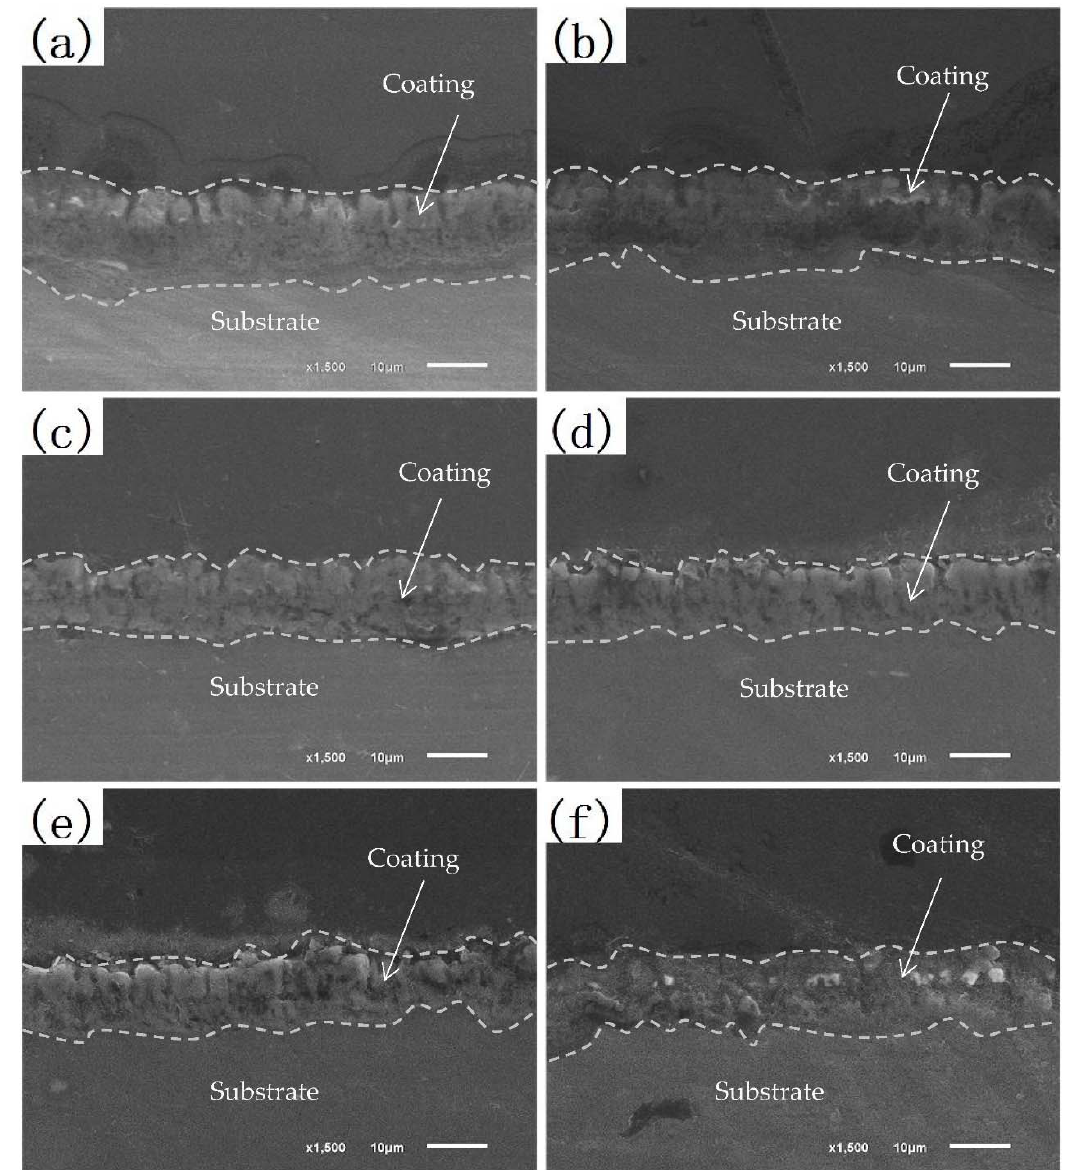
Figure 8. The cross-section morphology of MAO coatings after immersion in 3.5 wt % NaCl Figure 8. The cross ‐ section morphology of MAO coatings after immersion in 3.5 wt % NaCl solution: